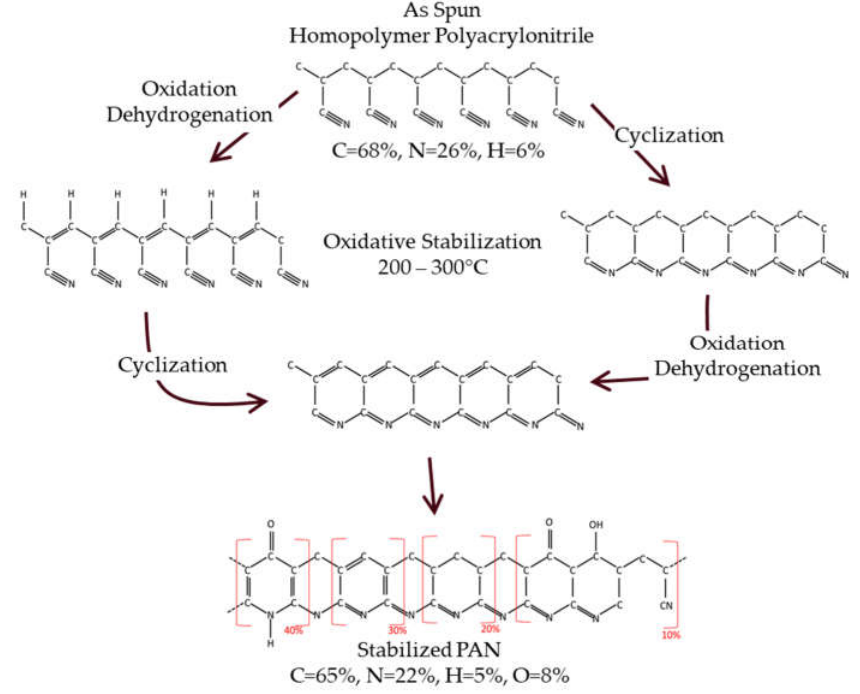
Figure 1. Polyacrylonitrile fiber stabilization process [24,25].